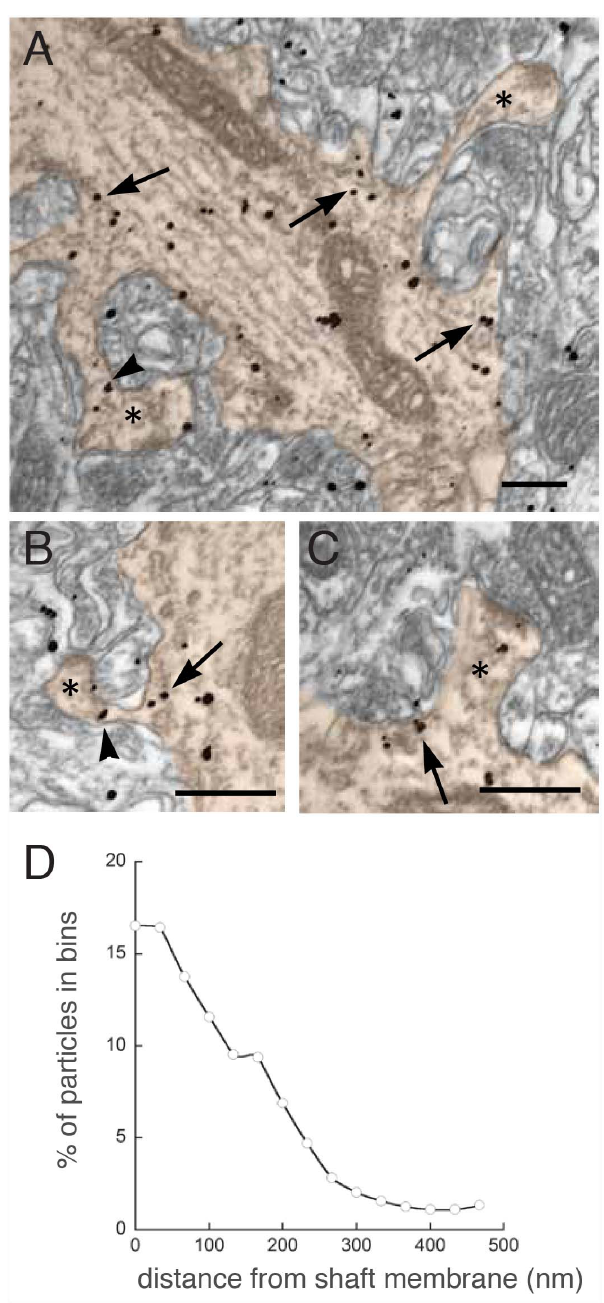
Fig. 2. Immunoelectron microscopy of Sept7 in hippocampus. (a–c) Electronmicrographs showing the neuropil of CA1 stratum radiatum; spines (asterisks) and dendritic shafts are highlighted in orange false color. Particles coding for Sept-7 were often concentrated at the base of the spine (arrows) within the dendritic shaft. Labeling was seen not only in spine heads (a, c) but also in spine necks (arrowheads in a, b). Scale bars, 200 nm. (d) Line graph showing a quantification of particle localization in respect to the distance from the dendritic plasma membrane. Approximately 60% of the immunogold particles are concentrated within 0– 100 nm from the membrane. The line graph was smoothened digitally using a three-point weighted running